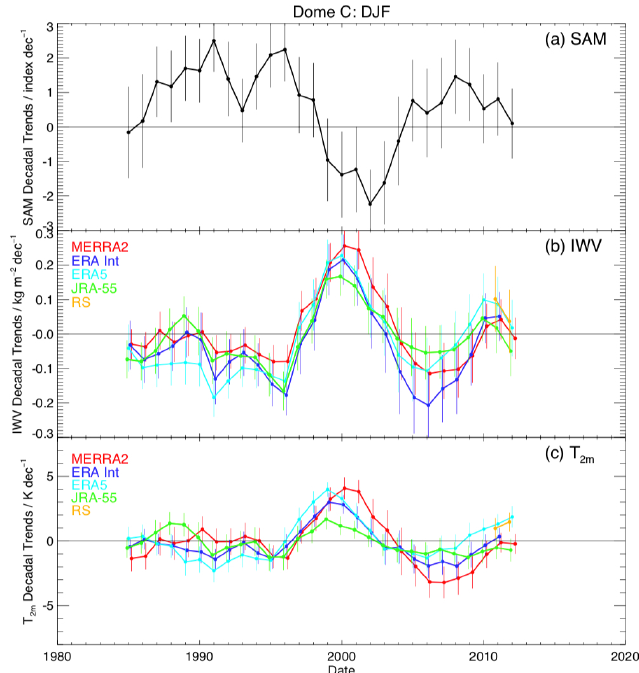
Figure 9. Multidecadal variability of the 10-year trends of ( a ) the SAM index, ( b ) the IWV and ( c ) the near-surface temperature (T 2m ) from the MERRA2 (red), ERA interim (dark blue), ERA5 (light blue) and JRA-55 (green) reanalyses above Dome C from 1980 to 2017 in summer (DJF). Superimposed are the 10-year trends of the IWV ( b ) and the 10-m temperature ( c ) from the radiosonde data set (orange) from 2005 to 2017. Vertical bars represent 1- σ error.